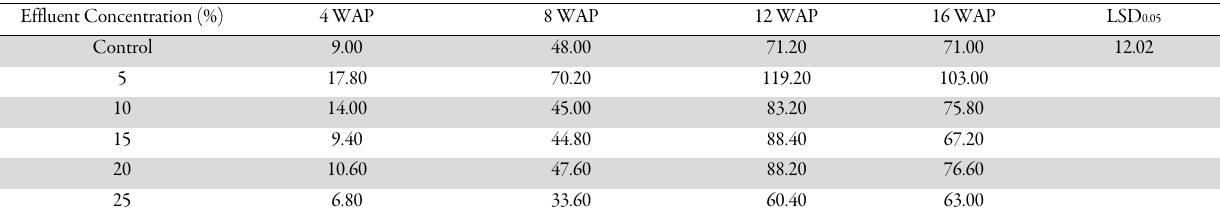
Table 3. Number of leaves of Solanum lycopersicum treated with different concentrations of detergent effluent Effluent Concentration